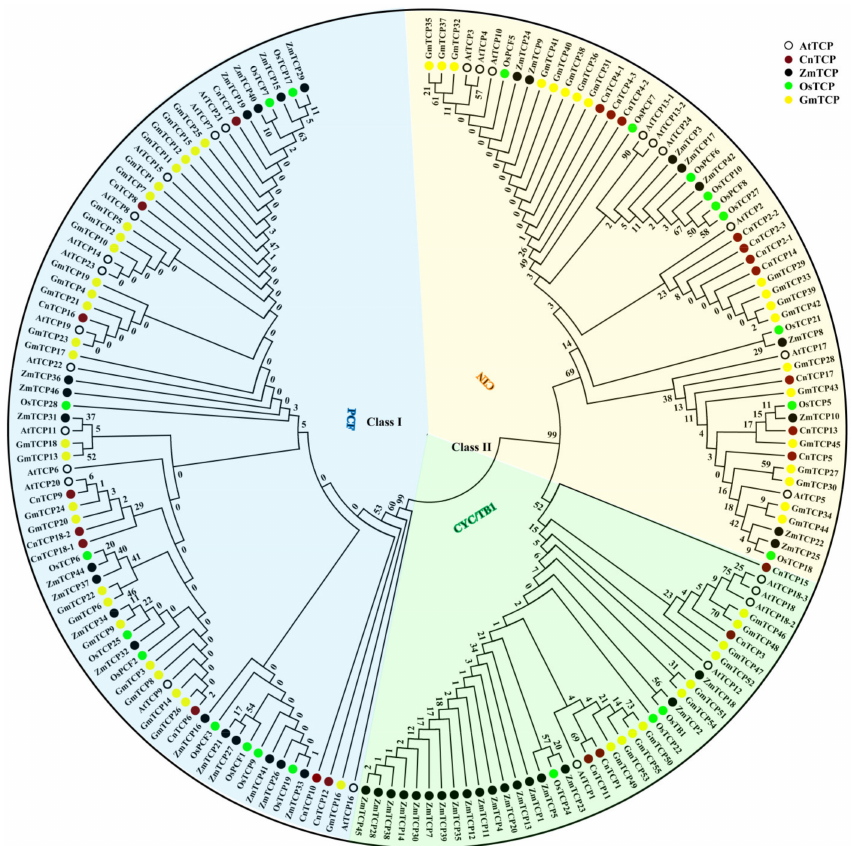
Figure 1. Phylogenetic relationships of CnTCP proteins. The phylogenetic tree was generated using the MEGA7.0 program; the bHLH domain amino acid sequences of TCP proteins from Glycine max (Gm), Oryza sativa (Os), Zea mays (Zm), Chrysanthemum nankingense (Cn), and Arabidopsis thaliana (At) were